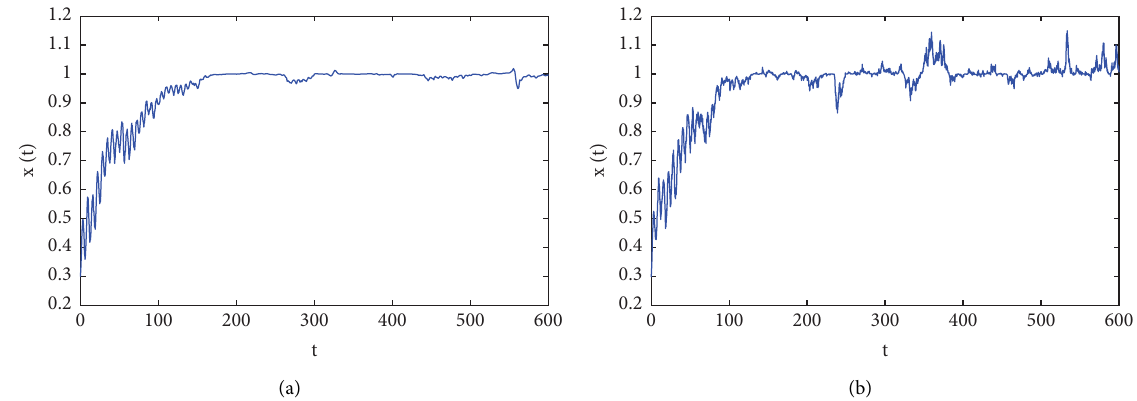
� 0 . 3, step size Δ ( t ) � 0 . 001. 0